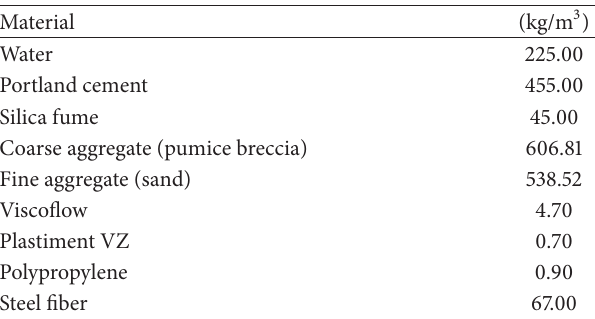
Table 2: Mixture proportion of HyFRLWAC as stay in-place formwork (substrate layer).